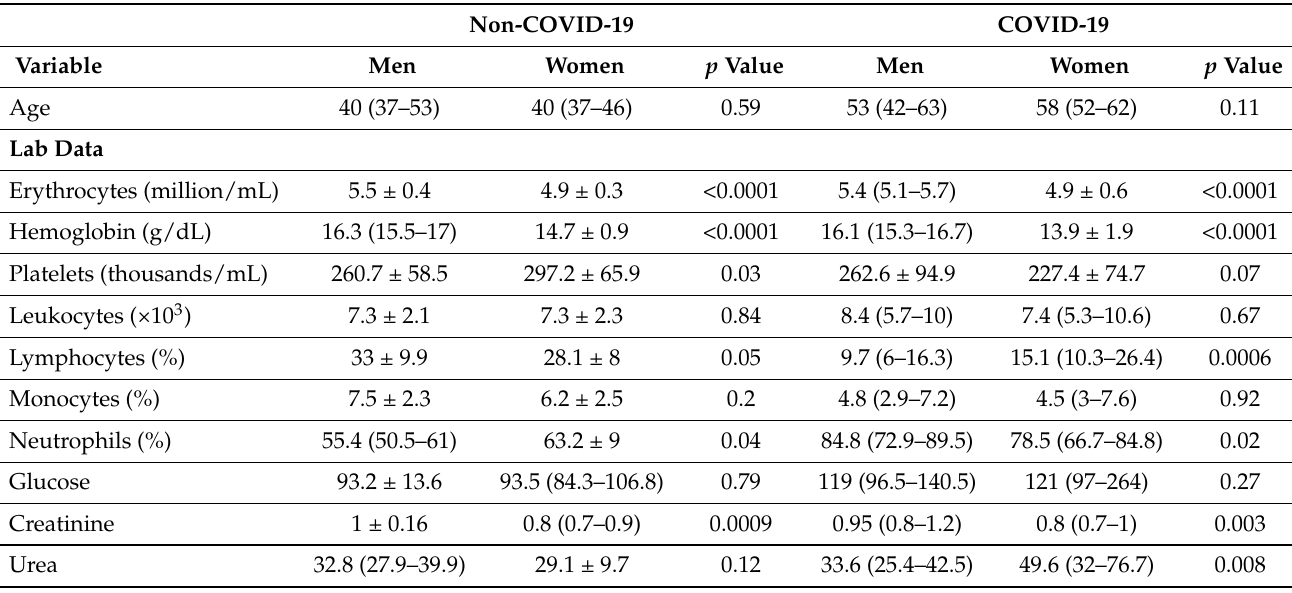
Table 1. Sociodemographic, epidemiological, and clinical characteristics, including laboratory analyses, of the study participants by